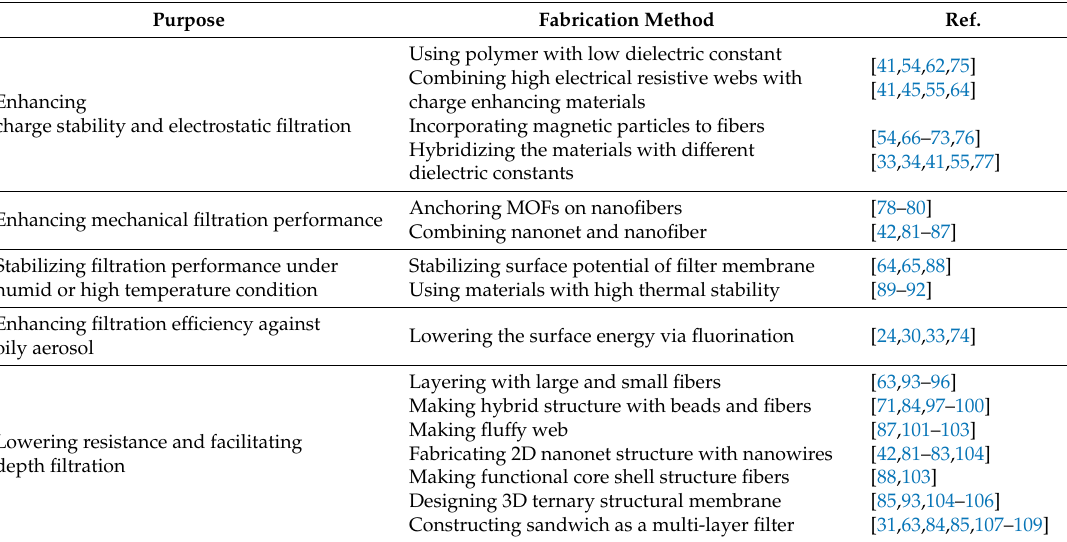
Table 2. Design strategies for advanced particulate filter